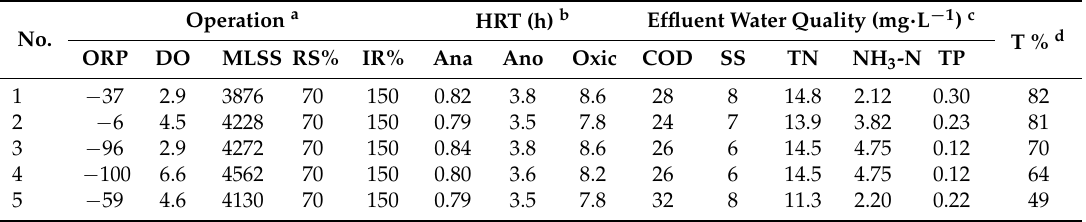
Table 1. Data mining outputs for the process operational optimization in Case-1 wastewater treatment plants